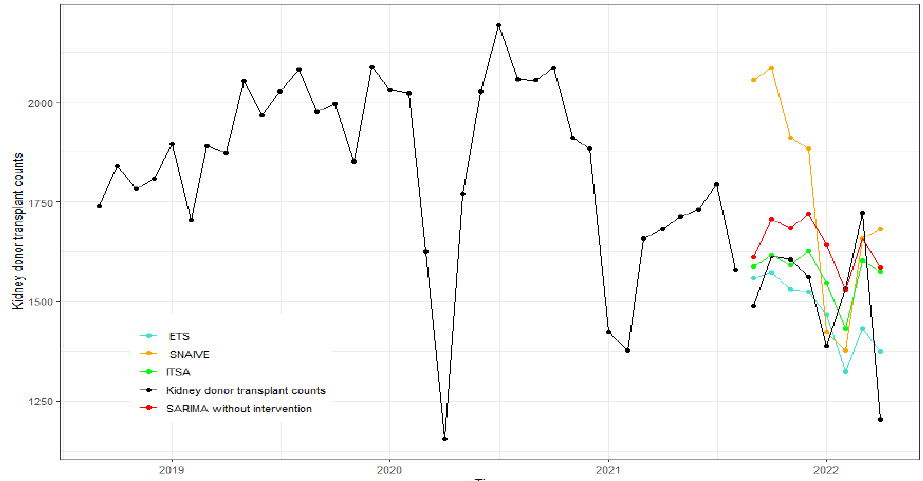
Figure 8. Forecasts of kidney donor transplant counts from September 2021 to April 2022 using ITSA, SARIMA without intervention, ETS, and SNAIVE.